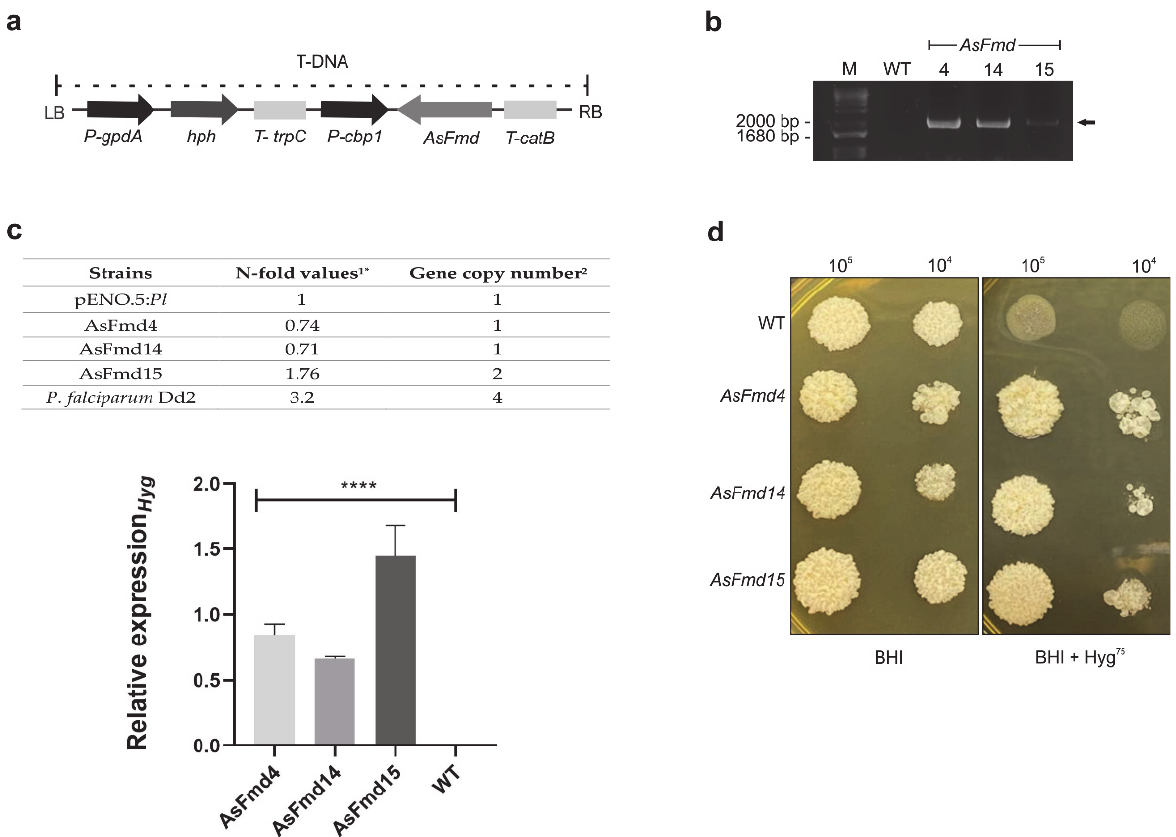
Figure 1. Confirmation of T-DNA integration into P. lutzii genome. ( a ) Schematic representation of the T-DNA generated for ATMT transformation. Antisense fmd fragment was constructed under control of calcium binding protein ( cbp1 ) promoter of H. capsulatum , and catB terminator of A. fumigatus . Hygromycin-resistant gene ( hph ) was constructed under control of glyceraldehyde 3-phosphatate dehydrogenase ( gpdA) promoter and trpC terminator of A. nidulans . ( b ) Confirmation of antisense plasmid integration on P. lutzii genome. Black arrow indicates the amplicon of 1800 bp on transformed strains. ( c ) Upper panel: Copy number of inserted Hygromycin into P. lutzii yeast cells accessed through qPCR. 1 * N-Fold copy number of AsFmd silenced strains of P. lutzii in comparison to luciferase promotor gene pENO.5:Pl that harbors one copy of hygromycin gene [35] and P. falciparum Dd2 that contains 4 copy numbers of multidrug resistance protein pfmdr1 gene [36]. N ‐ fold of P. lutzii was achieved by the average of triplicate of hygromycin expression levels. Hygromycin Ct values was normalized with enolase reference gene (PAAG_11169). 2 Linear regression was used for estimating the gene copy number in unknown silenced strains in relation to P. falciparum Dd2 [36] that contains 4 copy numbers and pENO.5: Pl that harbors one copy of hygromycin gene. The quantification of hygromycin expression in WT and AsFmd strains through RT-qPCR. The enolase gene (PAAG_11169) was used as endogenous control. Shapiro–Wilk test was employed to determine data normality ( p values > 0.1). Statistical analyses from experimental triplicates were